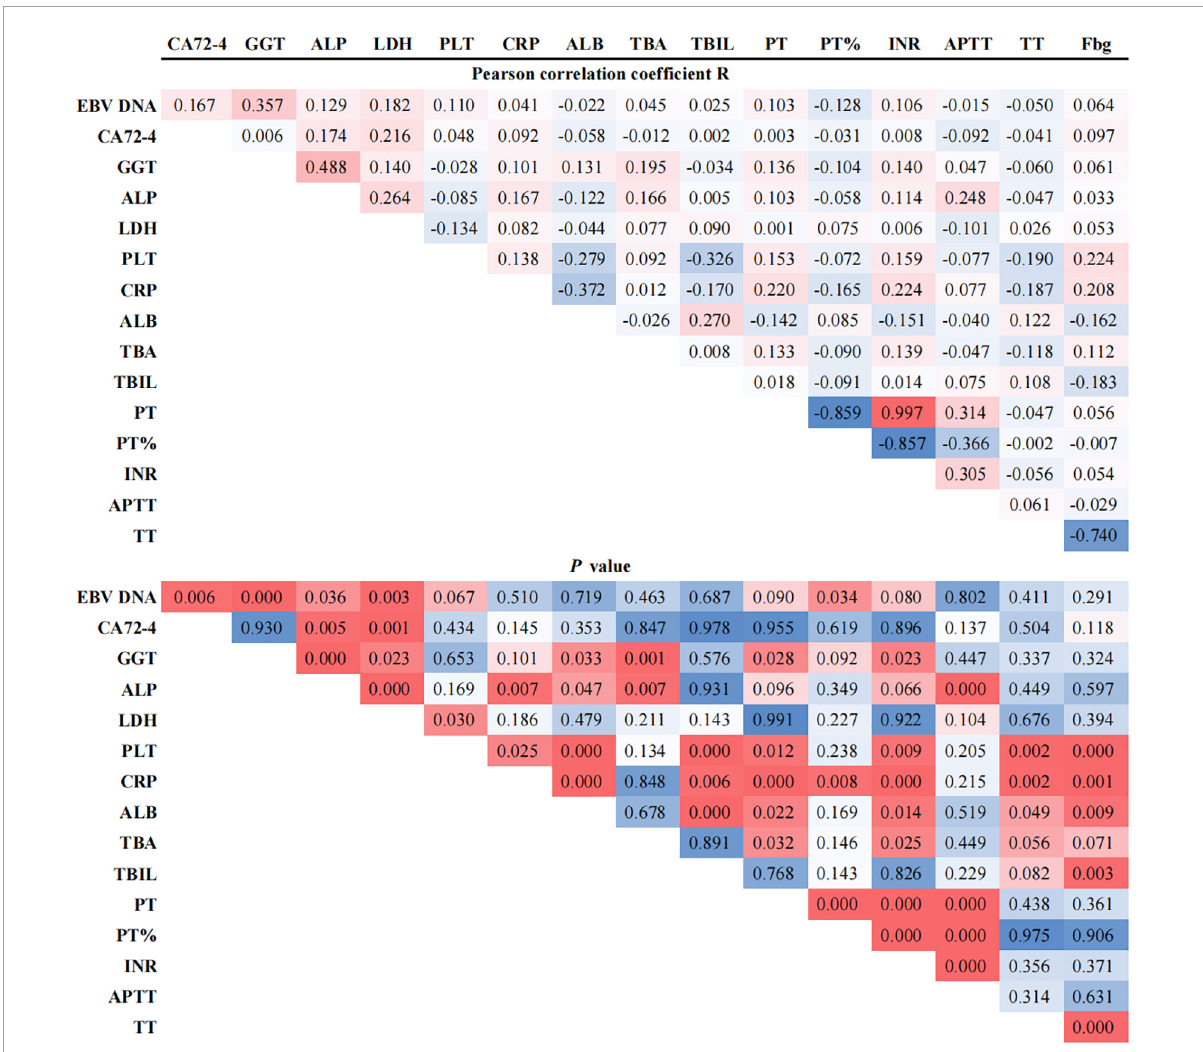
FIGURE2 Pearson correlation coefficients between EBV DNA and potentially associated laboratory